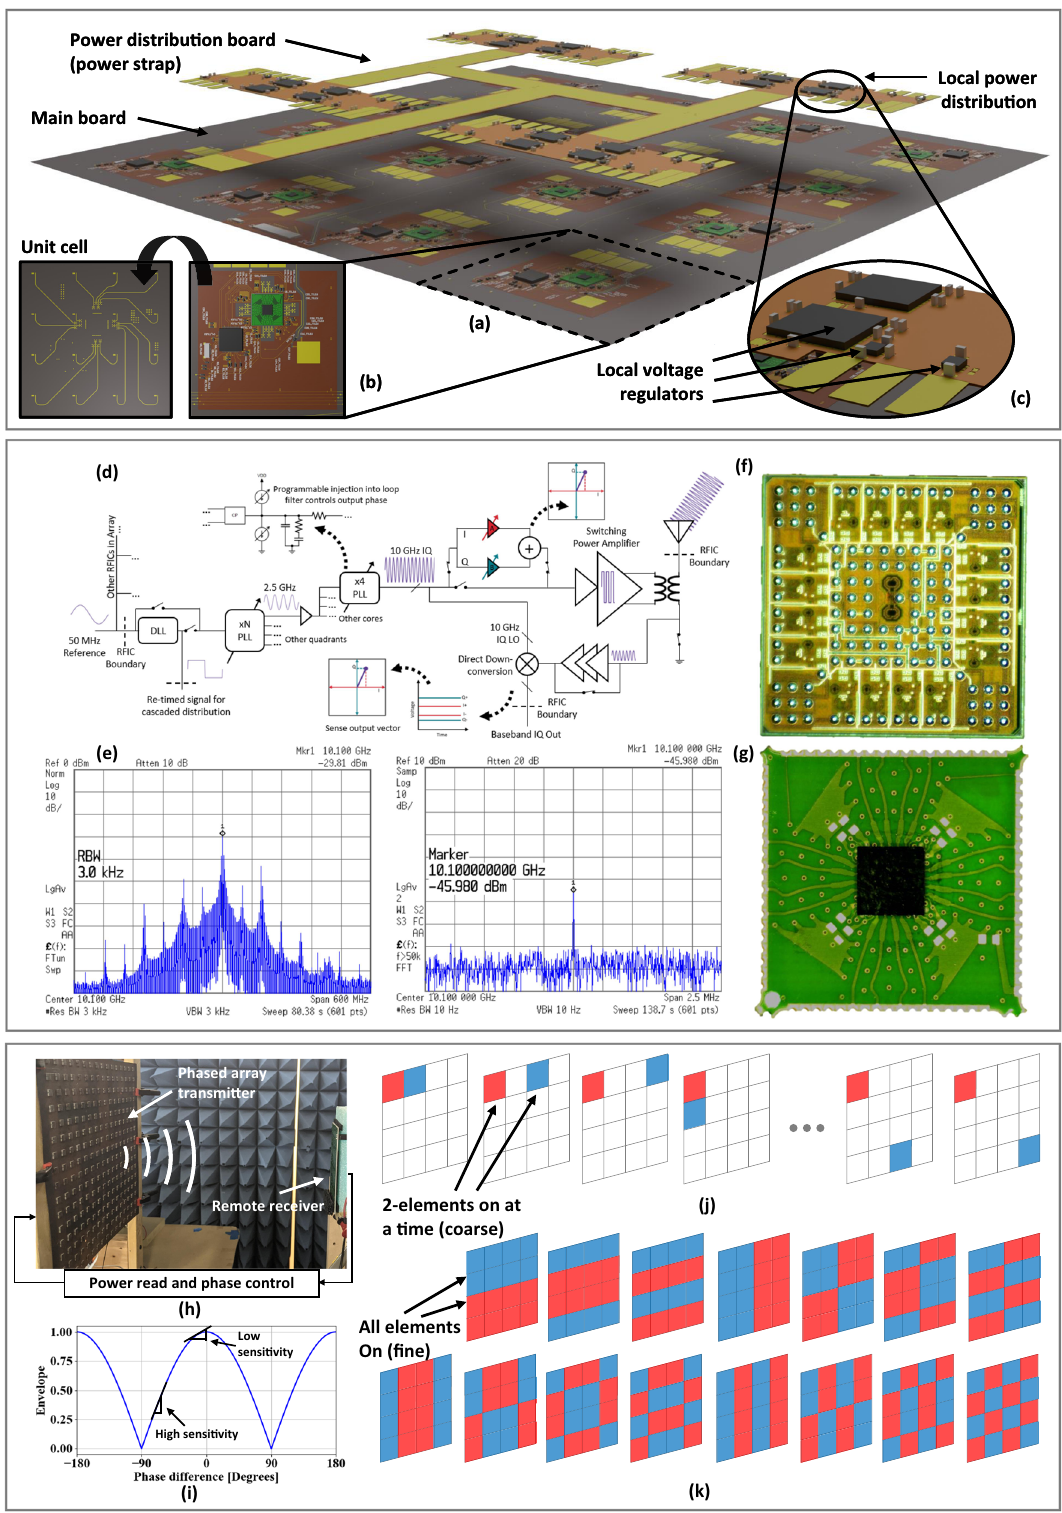
In addition to the essential signal synthesis and ampli fi cation functions, the chip possesses several features. Volatile memory cells control the weights of a vector sum phase rotator which can be bypassed for low power operation or used to enable rapid time multiplexing of the beam direction. Two of the 16